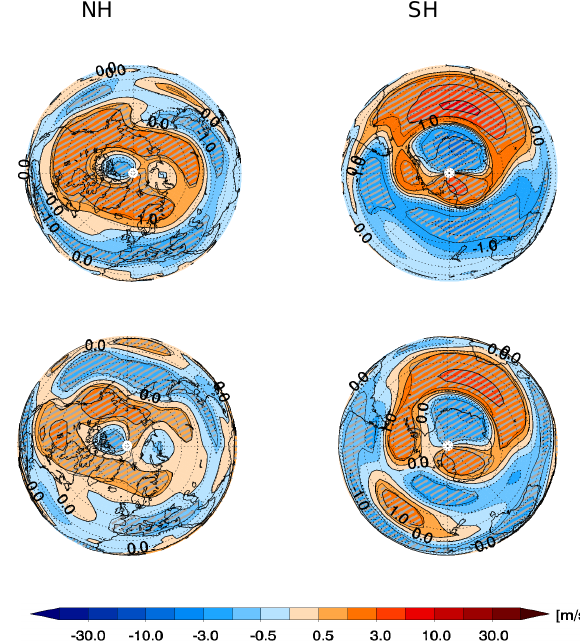
Fig. 6: Upper row: Polar stereographic projection of zonal wind changes at 25 hPa from August 458 Fig. 6. Upper row: polar stereographic projection of zonal wind to November given in m/s. Lower row: Zonal wind changes at 63 hPa from August to Novem- 459 changes at 25hPa from August to November given in ms − 1 . Lower ber given in m/s. Left column: NH. Right column: SH. Hatched areas show 95 % statistical 460 row: zonal wind changes at 63hPa from August to November given in ms − 1 . Left column: NH. Right column: SH. Hatched areas show 95% statistical